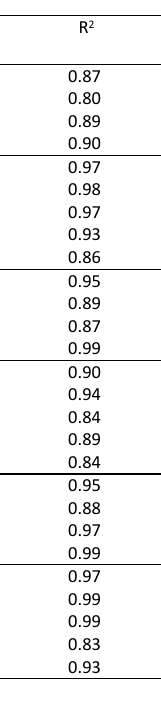
Table 5: First-order area-based removal rate constants for different HLRs and hybrid systems